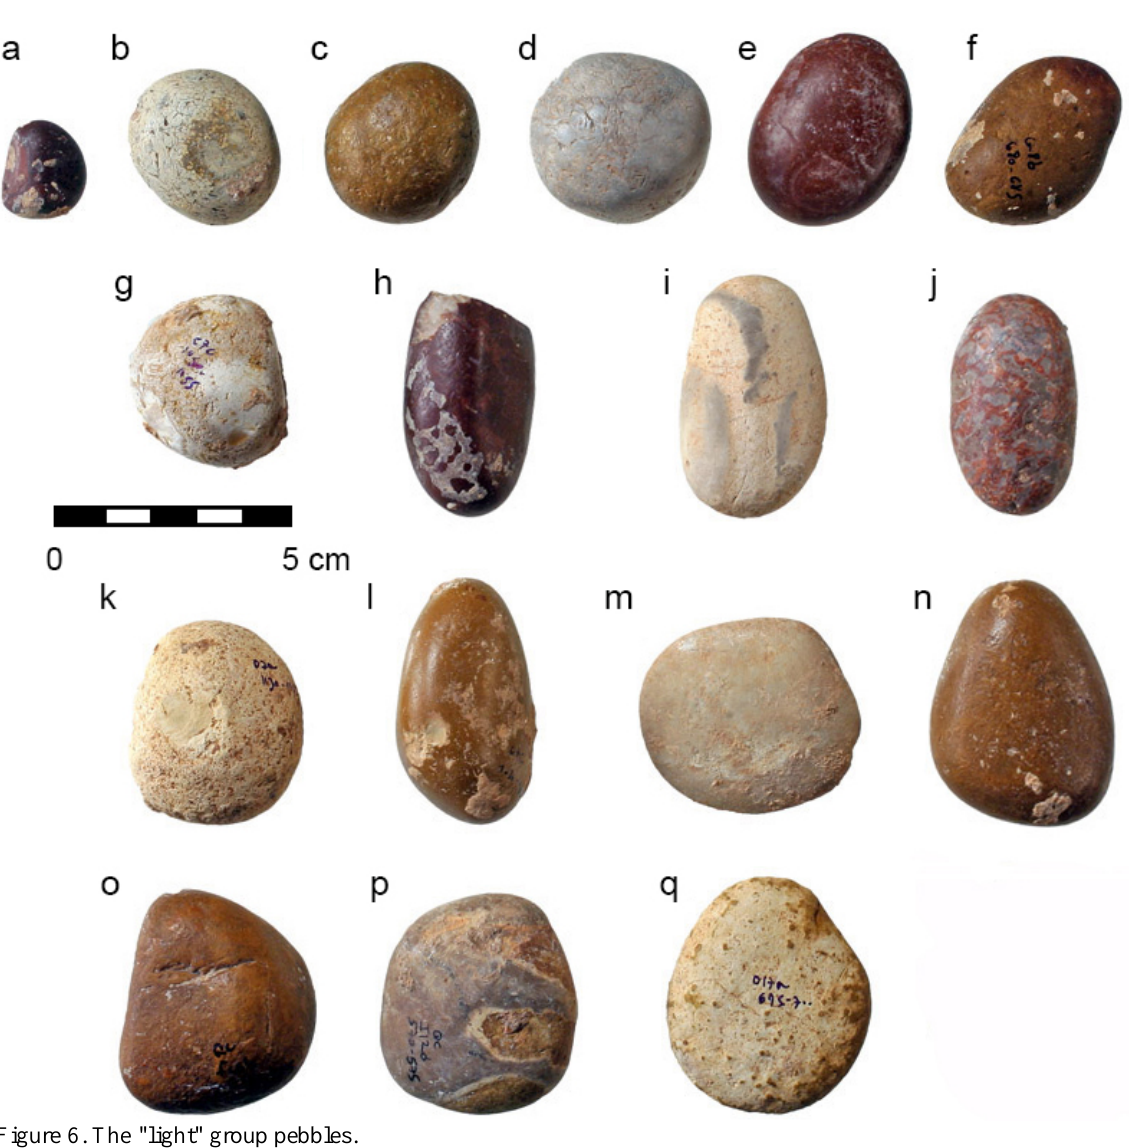
Figure 6. The "light" group pebbles.